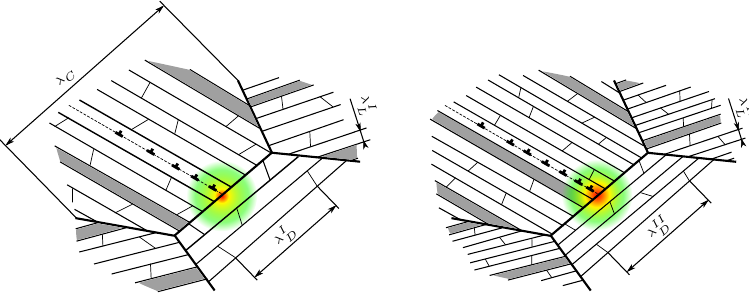
Figure 3. Illustration of dislocation pile-up stress at a colony boundary possibly activating slip/twinning in the adjacent colony. For λ II respective systems in the right image will be higher than in the left one, requiring a higher pile-up stress to be activated and thus making colony boundary strengthening a function of λ L and λ D